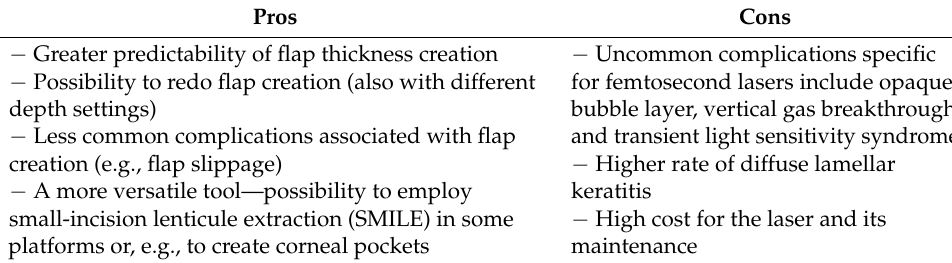
Table 3. Pros and cons of femtosecond